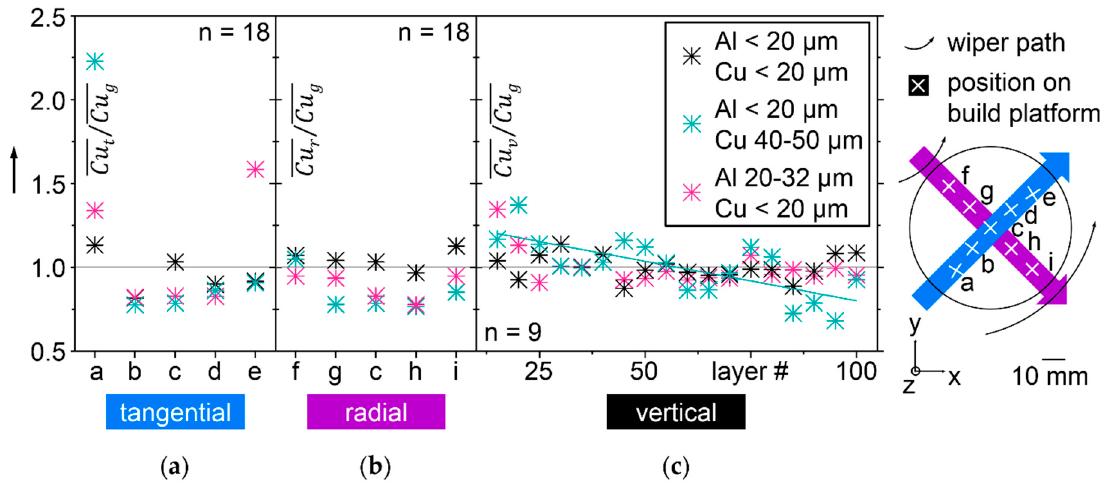
Figure 11. Homogeneity of Cu distribution compared by the ratios of local to global mean values for three binary Al-Cu powder mixtures with different PSD, determined by light microscopy of 60 µm powder layers in an LBM machine in three spatial directions; ( a ) tangential; ( b ) radial; ( c ) vertical. The comparison of Cu distribution between different layers spread subsequently at different vertical Z height over the build platform is illustrated in Figure 11c over the label vertical. It confirms the mixture with all particles < 20 µm as the most homogeneous one. The largest deviations from a ratio of means of one are found with Al particles < 20 µm and Cu 40–50 µm, a mixture that has been stable against segregation in vibrated bulk. With increasing Z height, optically detectable Cu in layers of this mixture decreases. A fitted teal line in Figure 11c indicates this tendency. The mixture with larger Al than Cu particles shows less variation of Cu content over the number of layers than the one with larger Cu particles, but more than the mixture with all particles < 20 µm. In summary, the best homogeneity in vibration as well as spreading of thin layers is found in the mixture with all particles < 20 µm dry coated with SiO x . Segregation results in thin layers differ significantly from the results of vibrated test tubes. The mixture with larger Cu particles, which is stable under vibration, shows more segregation in thin layers than the mixture with larger Al particles, which is less stable under vibration. Conditions for de-mixing during spreading of thin layers differ significantly from vibrated bulk powder. They can be characterized by the moving wiper, that appears to selectively transport Cu by convection [37]. This selective transport is pronounced for the mixture with larger Al and the mixture with larger Cu. The mixture with all particles < 20 µm is least affected by this selectivity and stays most homogeneous in comparison. Uniform particle size in a range that decreases effect of particle mass appears to be beneficial for stability against de-mixing during spreading of thin layers. The mixture with larger Cu showed highest Cu content at the location closest to the turning point of the wiper, which resembles the results with all particles > 20 µm without SiO x , as shown in Figure 6a. The mixture with larger Al shows highest Cu content at location e, which is the furthest from the turning point of the wiper. A second, less pronounced peak of Cu content of the mixture with larger Al is found at location e, closest to the turning point of the wiper. Based on the current results, it cannot be excluded that another combination of particle size and mass may compensate for the selectivity of convective transport. This would probably be a powder mixture that is not stable against de-mixing under vibration, as the mixture with Al < 20 µm and Cu 40–50 µm segregated. To better understand the details of de-mixing phenomena during spreading of thin layers, it might be revealing to capture the powder movements in front of the wiper, in videos resolving single particles. Layer thickness, wiper geometry, and wiper velocity appear as probable influencing factors.